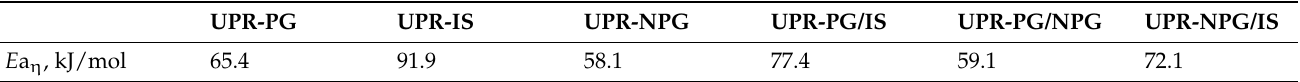
Table 1. Activation energy of flow (Ea η ) at the constant shear rate (10 s − 1 ) of examined UPRs. UPR-PG UPR-IS UPR-NPG